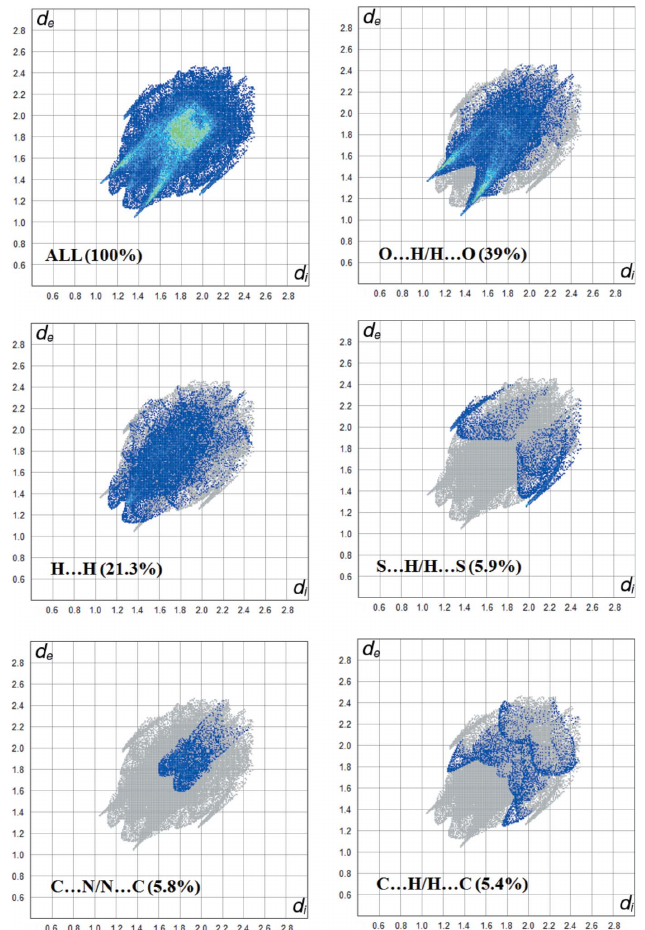
Figure 4 Two-dimensional fingerprint plots for the title compound, with the relative contributions of the atom pairs to the Hirshfeld surface.